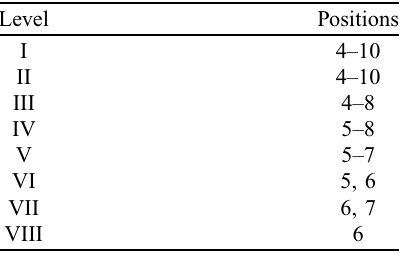
Table 2. Groups of positions for external fixation